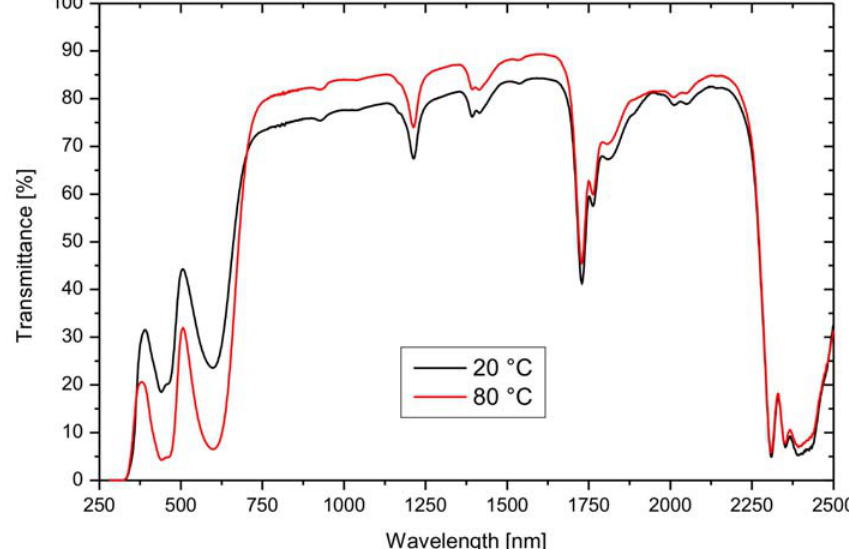
Figure 9. Normal-hemispherical transmittance of a thermochromic film with a green dye at different temperatures